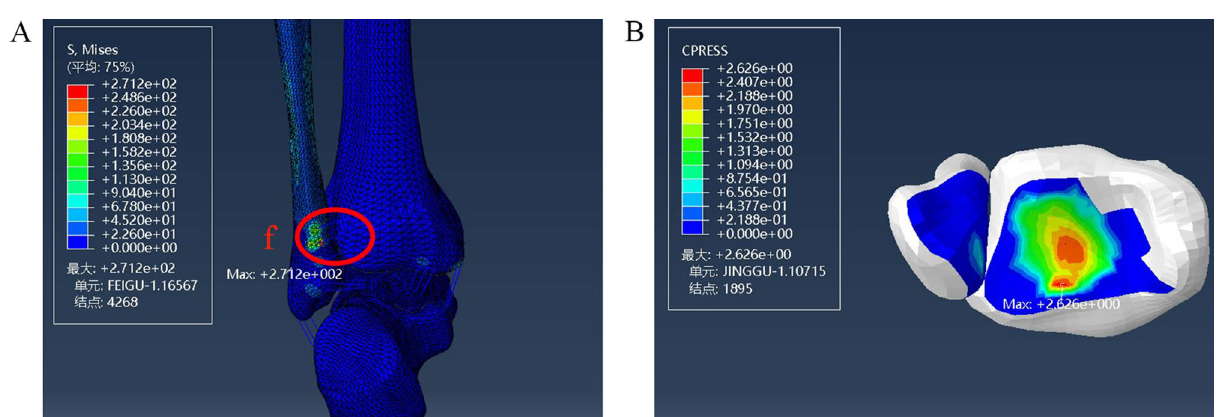
Figure 6. Distribution of stress during injury to the anterior tibiofibular ligament in a supination-external rotation ankle injury. ( A ) Maximum stress view. ( B ) Maximum contact stress view. Units of measurement: Mpa. f: The posterior tibiofibular ligament.